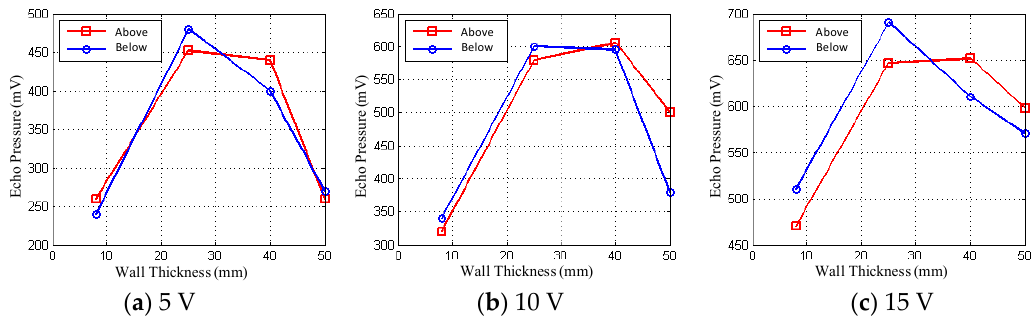
Figure 5. Average echo pressures at various wall thicknesses of the Excitation voltage 5 V, 10 V, 15 V. Table 2. Distinguishing characteristics of variable amplitude excitation under different wall thicknesses.